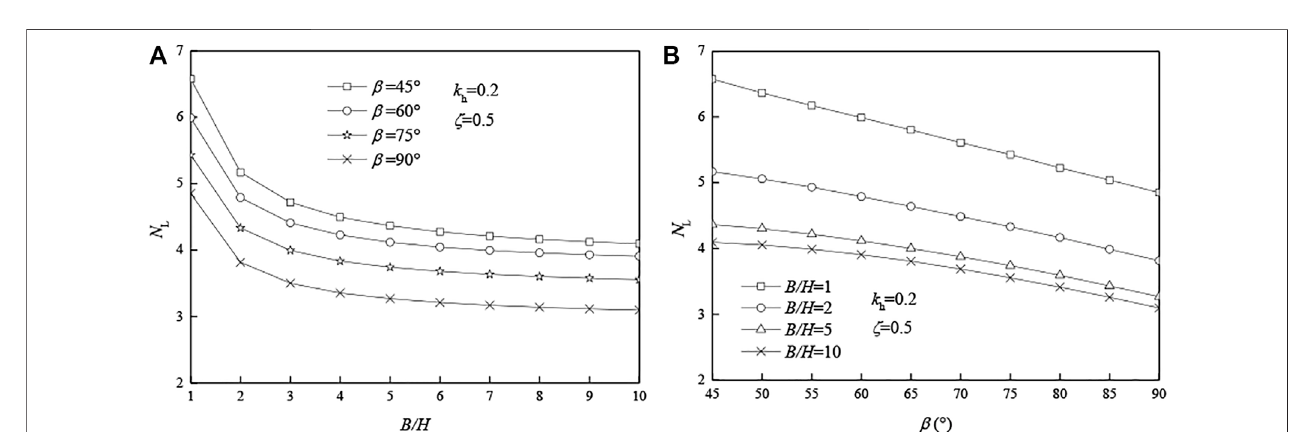
FIGURE 3 | Effects of the ratio B/H and slope angle β on stability factor N L : (A) B/H ; (B) β .